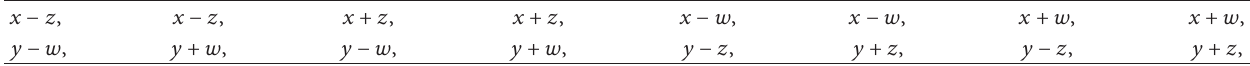
Table 3: Irreducible components corresponding to